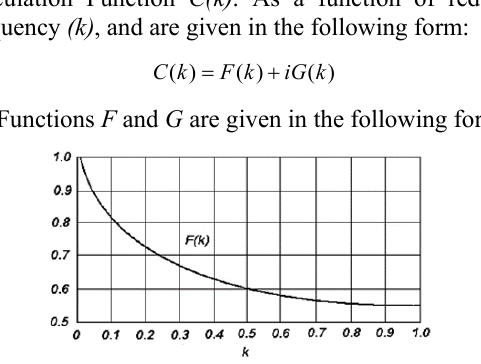
Figure 8. Circulation function real part F(k) as a function of a reduced frequency